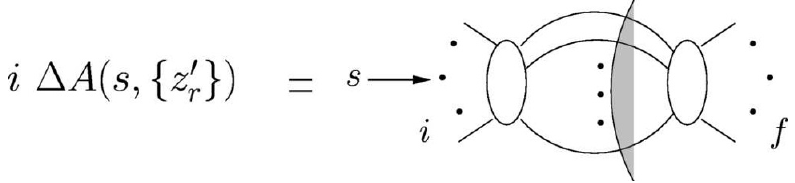
Figure 5 . Discontinuity across normal threshold given by eq. (6.10). Energy flows from unshaded to shaded side of cut (on-shell) lines. Feynman rules on shaded side are those for T †